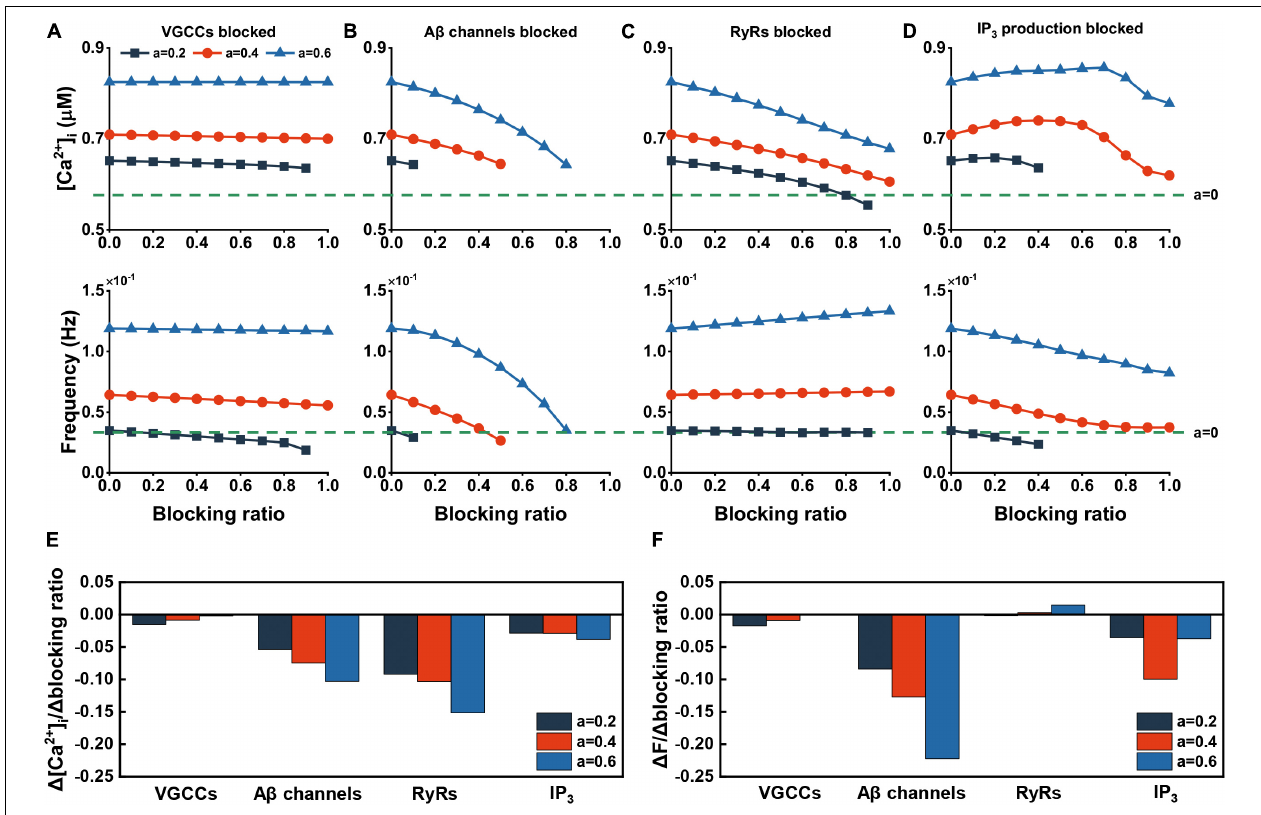
FIGURE 7 | Effect of blocking channels, receptors, and products. (A–D) The changes in amplitude and frequency after different blocking ratios of related channels, receptors, and products. The green dashed line represents the absence of A β . (E) Amplitude sensitivity of recovery effect. The sensitivities are calculated by the slope in (A–D) . (F) Frequency sensitivity of recovery effect. The sensitivities are calculated by the slope in (A–D)